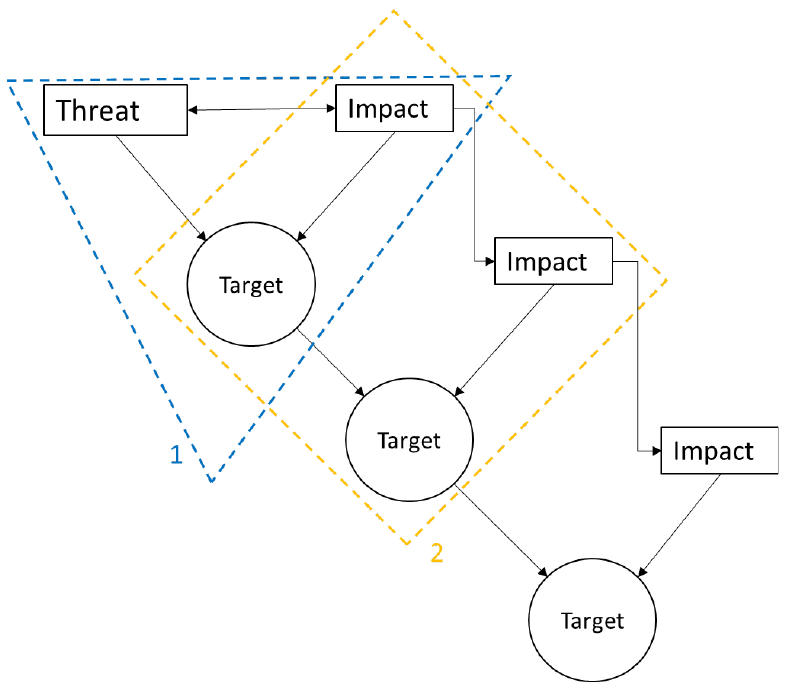
Figure 5. Mapping of the Impact Propagation.